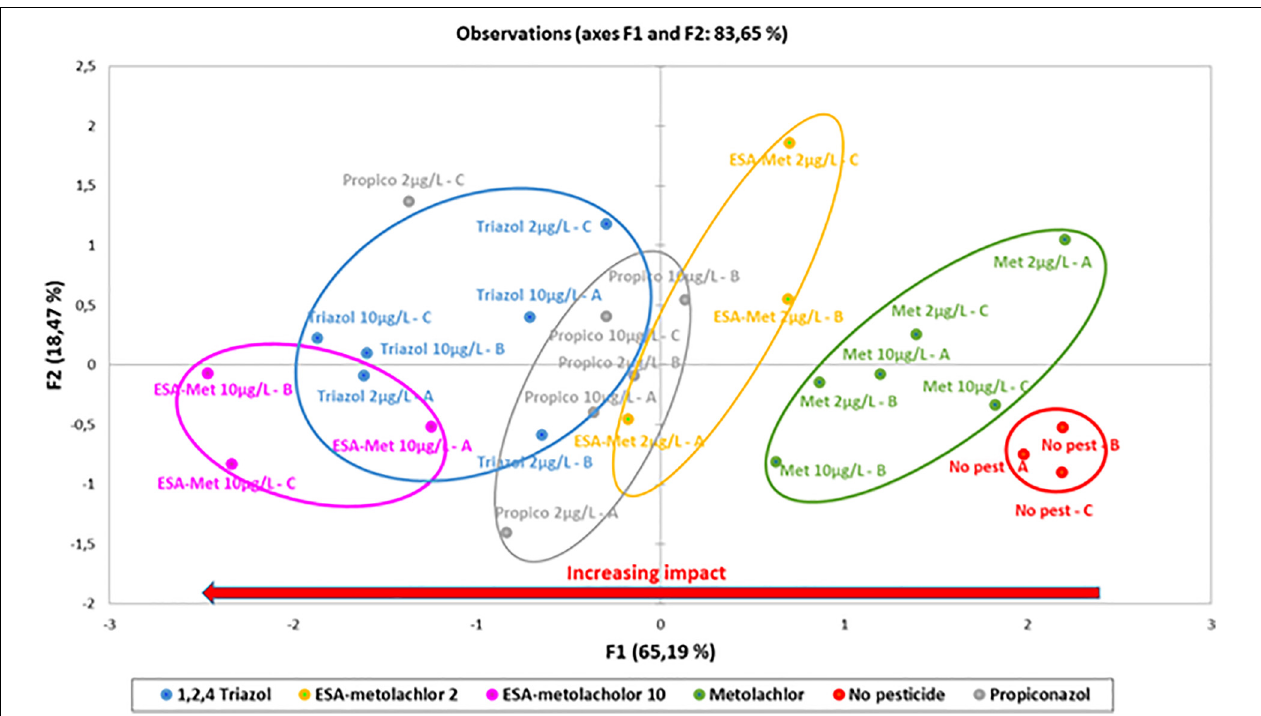
FIGURE 4 | Principal component analysis (PCA) of potential denitrification parameters measured during batch experiments in the presence or absence of pesticides at 2 or 10 µ g/L. The percentages of explained variations for the first two axes are indicated within the figure. No pest: control (absence of pesticides or metabolites); Met: metolachlor; ESA-met: ESA-metolachlor; Propico: propiconazole; Triazol: 1,2,4-triazole. 2 and 10 are pesticide or metabolite concentrations in µ g/L. A, B, and C are